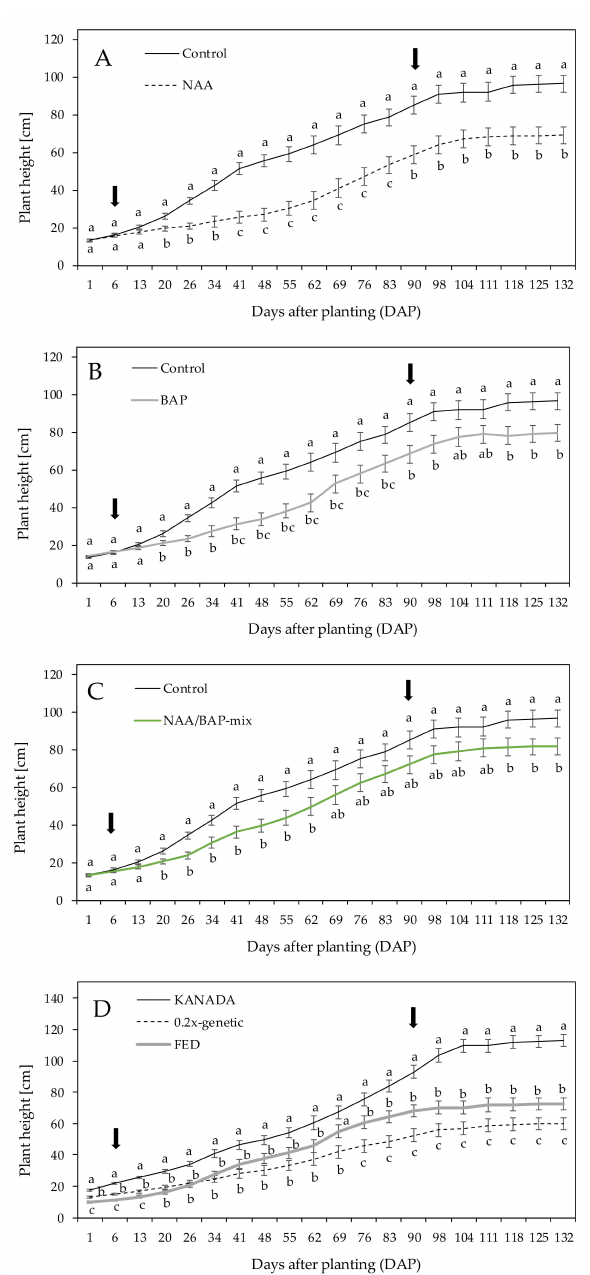
Figure 1. Mean plant height over all three tested genotypes treated with ( A ) 1-naphthalenacetic acid (NAA), ( B ) 6-benzylaminopurine (BAP), and ( C ) NAA / BAP-mix, compared to the nontreated control over a time period of 132 days after planting (DAP). ( D ) Mean plant height of genotype KANADA, 0.2x-genetic, and FED over 132 days. Means covered with at least one identical lowercase letter did not di ff er significantly at α = 0.05. The arrows show the period (6 to 90 DAP) during which application took